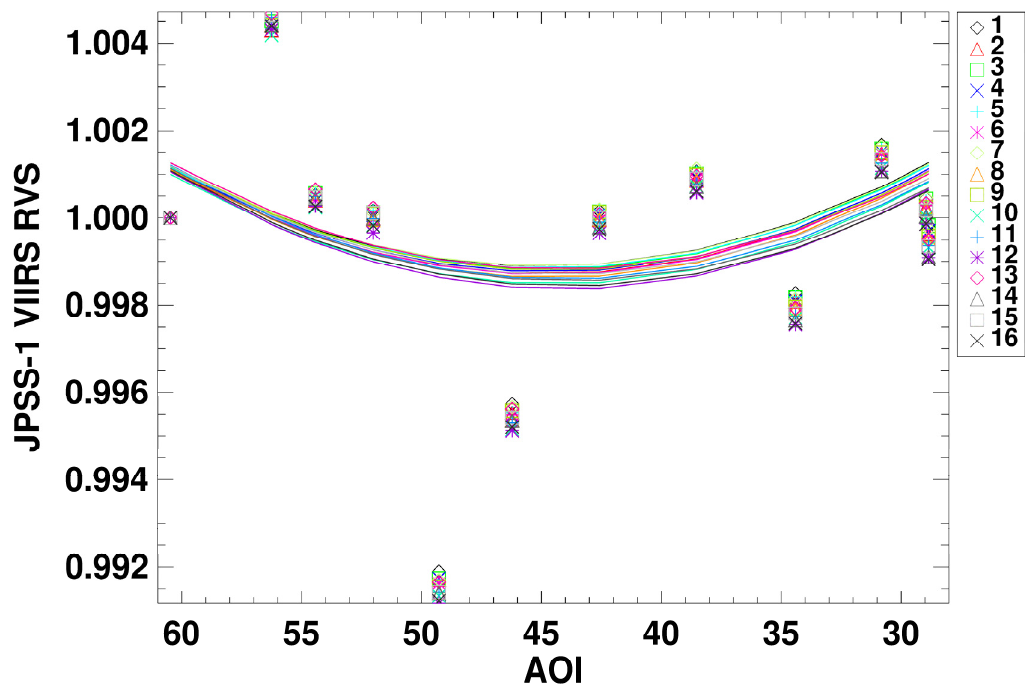
Figure 6. Band M9 HAM side A RVS and Fits for all Detectors.